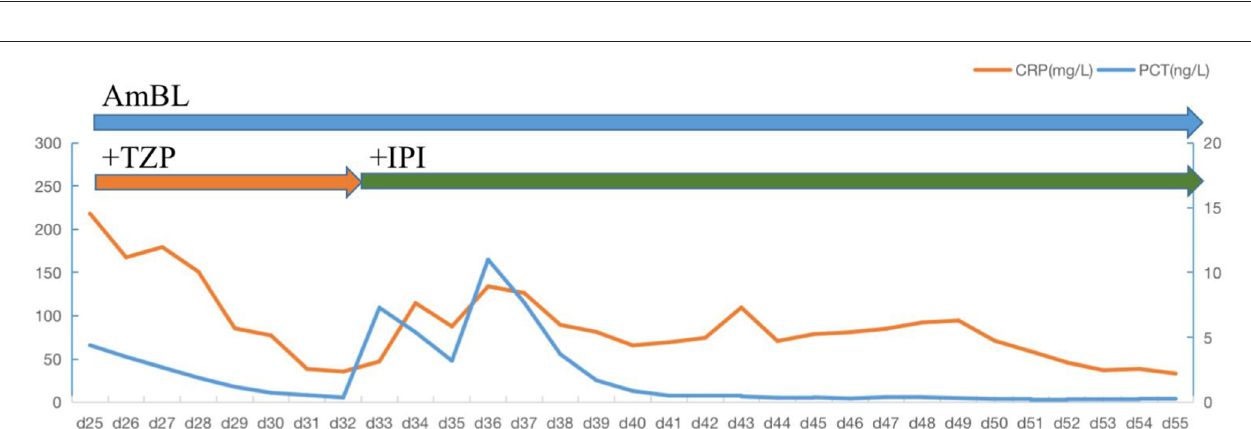
FIGURE 4 | Daily course of the patient’s treatment. Horizontal thick blue lines show the medications administered; VRC, voriconazole; AmBL, Liposome-associated amphotericin B; TZP, piperacillin-tazobactanm; IPI, Imipenem; PCT, procalcitonin; CRP, C-reactive